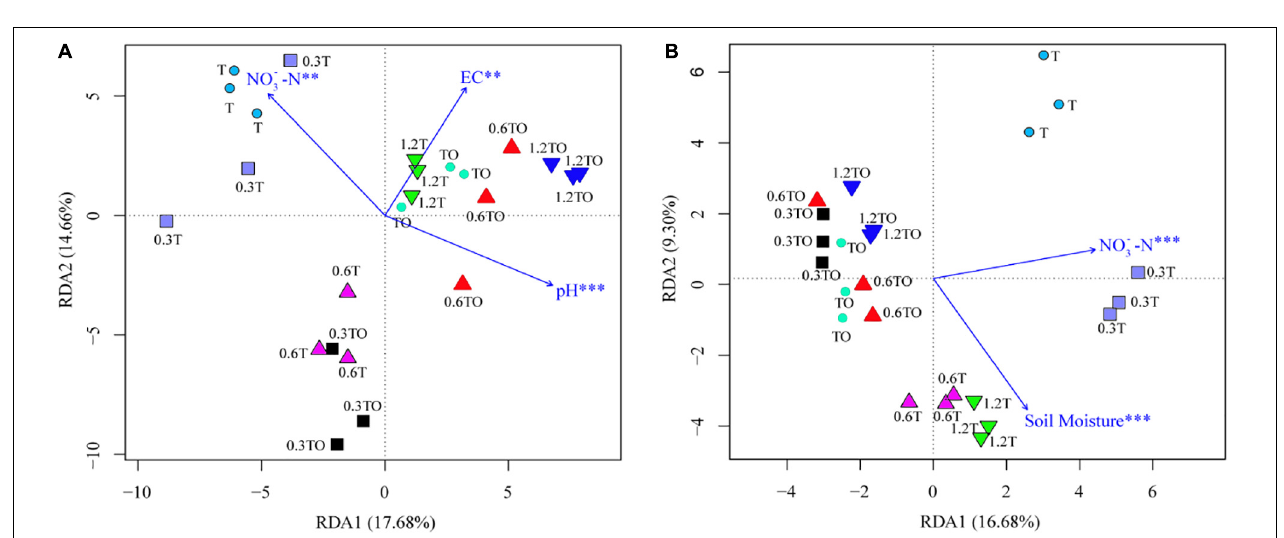
FIGURE 6 | Non-metric multidimensional scale (NMDS) analysis of bacterial (A) and fungal (B) community structures based on Bray-Curtis distances at the OTU level. T and TO indicate tomato monoculture and intercropped with potato–onion, respectively. 0, 0.3, 0.6, and 1.2% indicate the biochar rates.